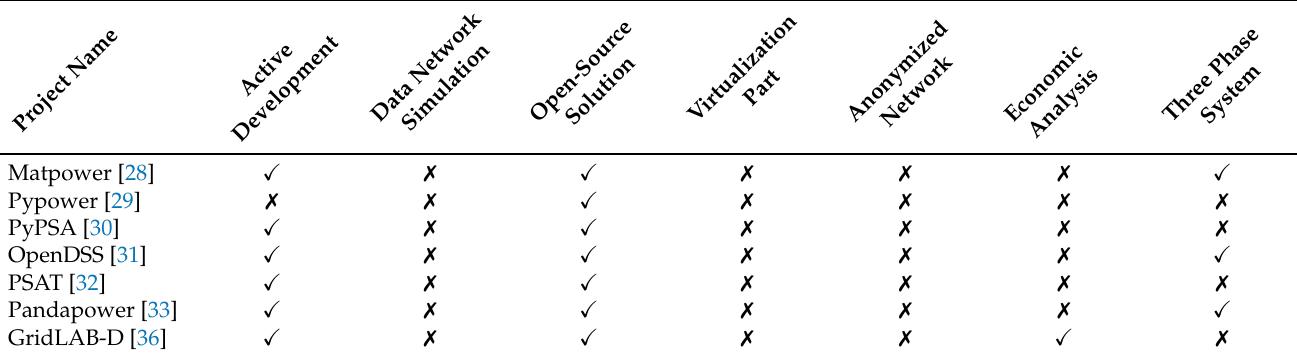
Table 2. Comparison of Available Power Grid Simulators.